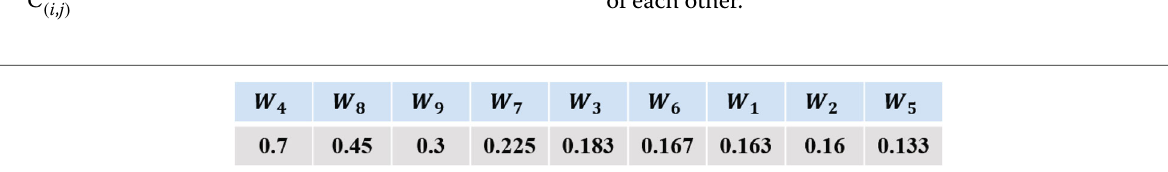
Fig. 7 The weights of sensors in the example showed in Fig.